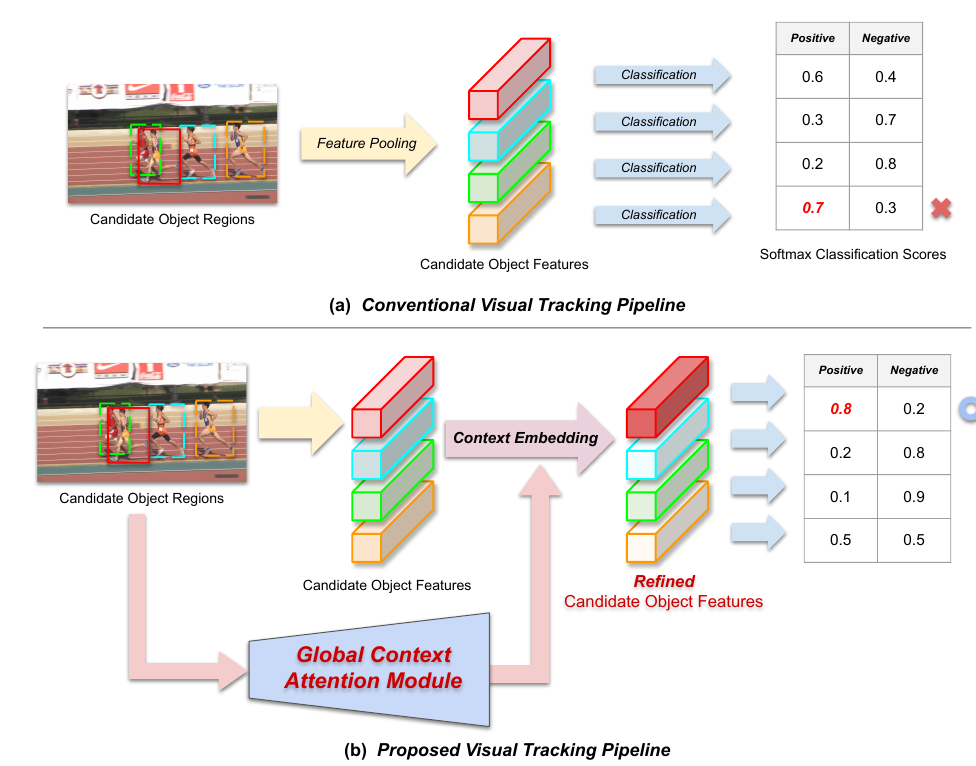
Figure 1. Motivation for the proposed tracking